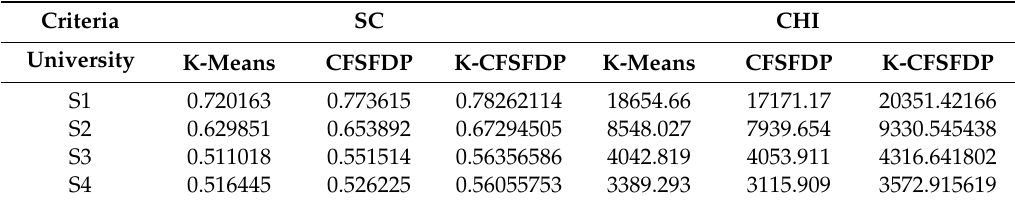
Table 6. Silhouette coe ffi cient (SC) and Calinski–Harabasz index (CHI) value of the three algorithms.